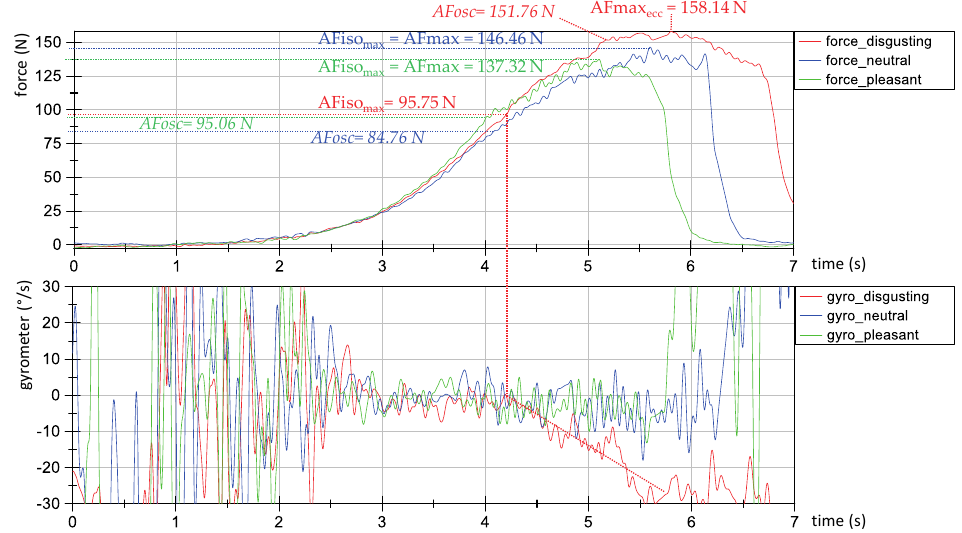
Figure 12. Oscillations during MMT measurements in interaction of tester and participant. Exemplary force (above) and gyrometer signals (below) during MMT measurements using the handheld device. An experienced tester performed the MMT of the hip flexors of one female participant during disgusting (red), neutral (blue) and pleasant (green) odors. The force values (N) for the parameters maximum Adaptive Force (AF max ), maximum isometric Adaptive Force (AFiso max ) and the Adaptive Force in the moment of oscillation onset (AF osc ) are